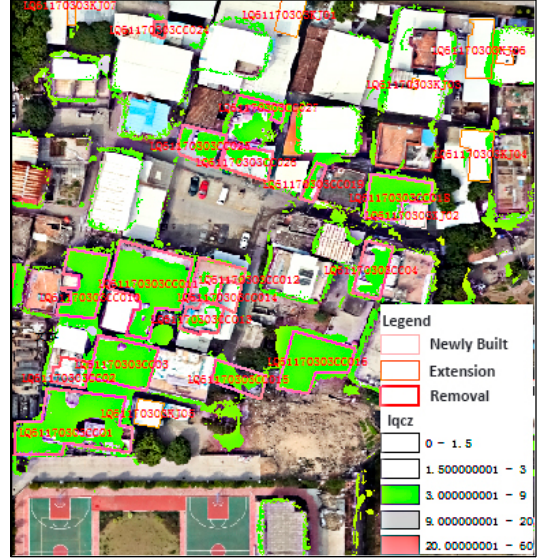
Figure 6. Example of artificial visual interpretation results.